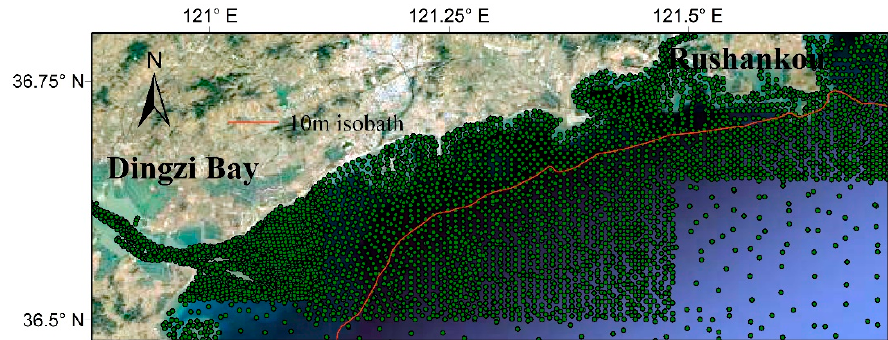
Figure 3. The distribution of dots from Rushankou to Dingzi Bay, 2019.